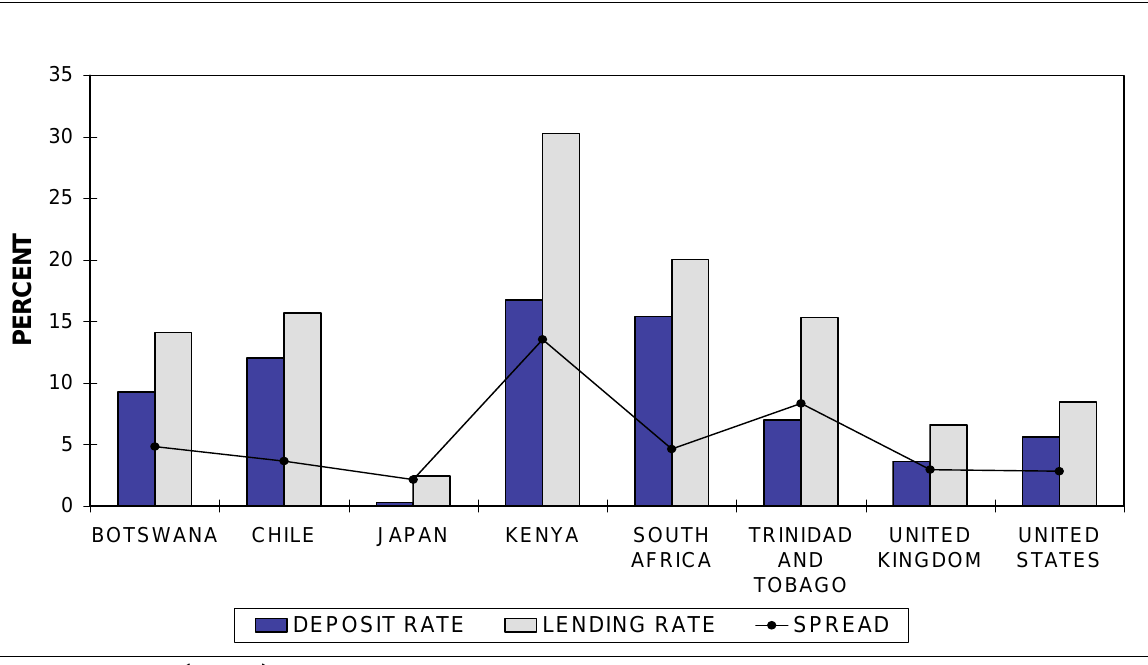
Interest rates and spread in 1997 for selected